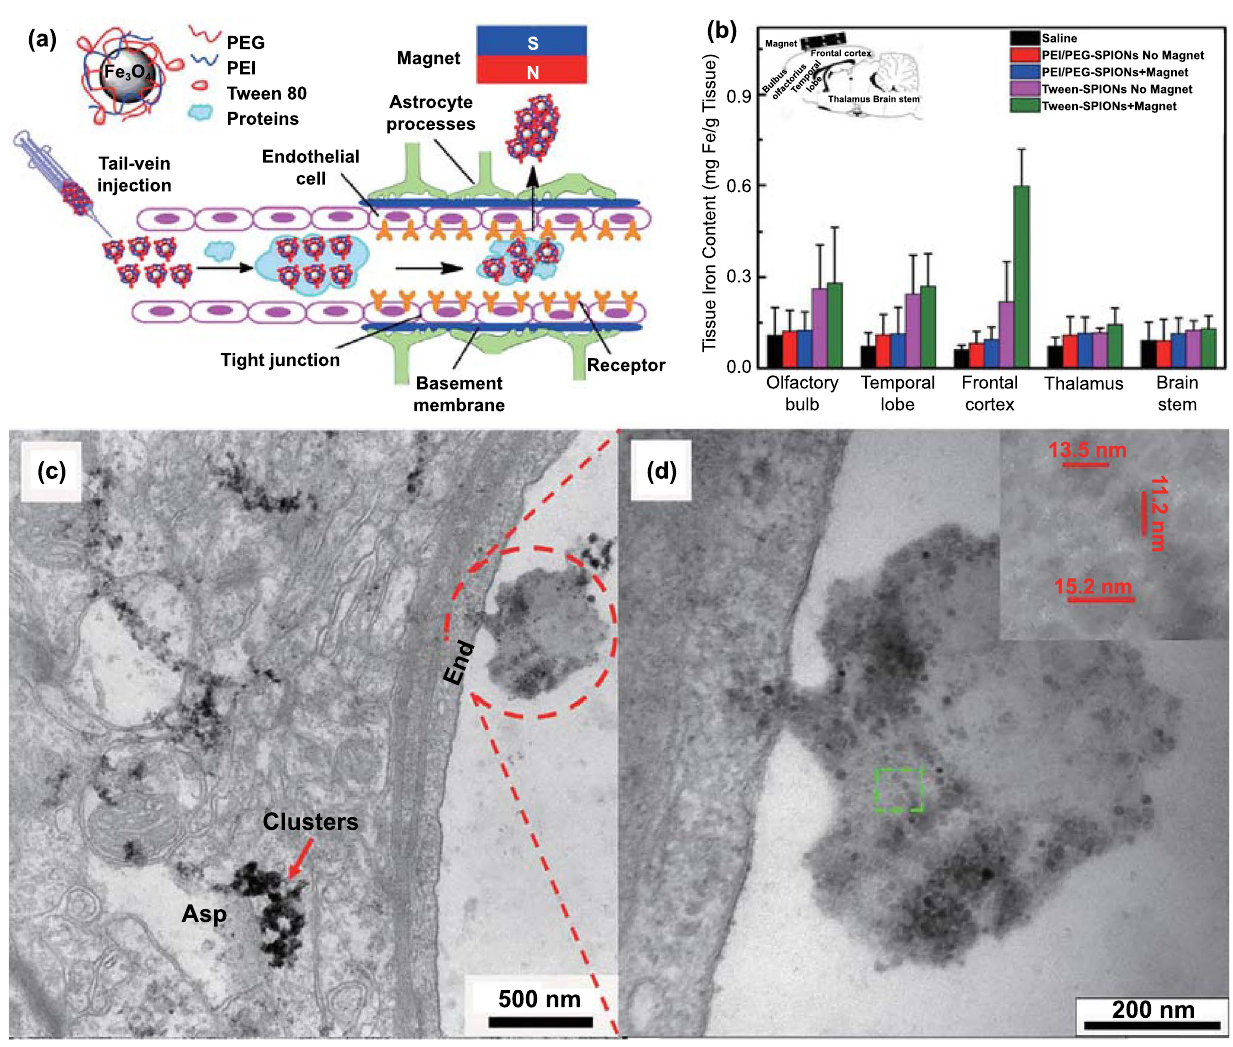
Fig. 7 Example of magnetic force-mediated brain delivery. a Schematic illustration for Tween-SPIONs crossing the BBB in the presence of a magnet. b The distribution of iron in different brain areas in rats 2 h after tail vein injection. The inset image indicates the position of the mag- net. c SPIONs enter the brain by crossing the BBB. Asp: astrocyte processes, End: endothelial cell. d Higher magnification image; the inset shows the size of the SPIONs. Adapted with permission from Ref. [162]. Copyright 2016 American Chemical